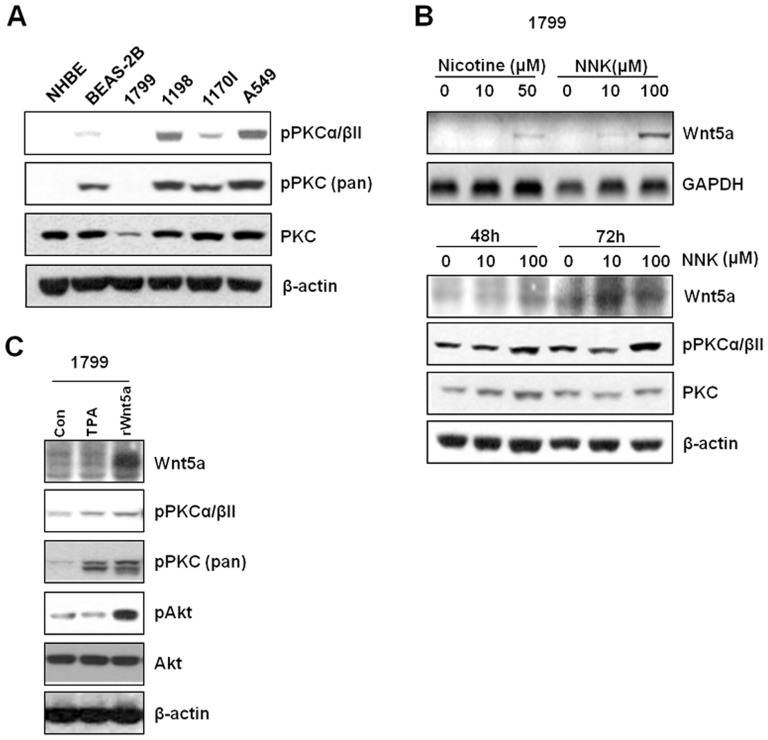
Wnt5a causes activation of PKC and AKT signaling.(A) The phosphorylation status of PKC α/βII and PKC-pan in 5 HBE cells by Western blot analysis. (B) Treatment with cigarette smoking carcinogens, 50 µM nicotin and 100 µM NNK, increases the levels of Wnt5a mRNA expression in 1179 cells. The phosphorylation status of PKC α/βII and PKC-pan was analyzed by Western blot analysis after treatment with 100 µM NNK for 48∼72 h. (C) 1799 cells were treated with recombinant Wnt5a. TPA was used as a positive control to stimulate PKC. β-actin was used as a loading control.